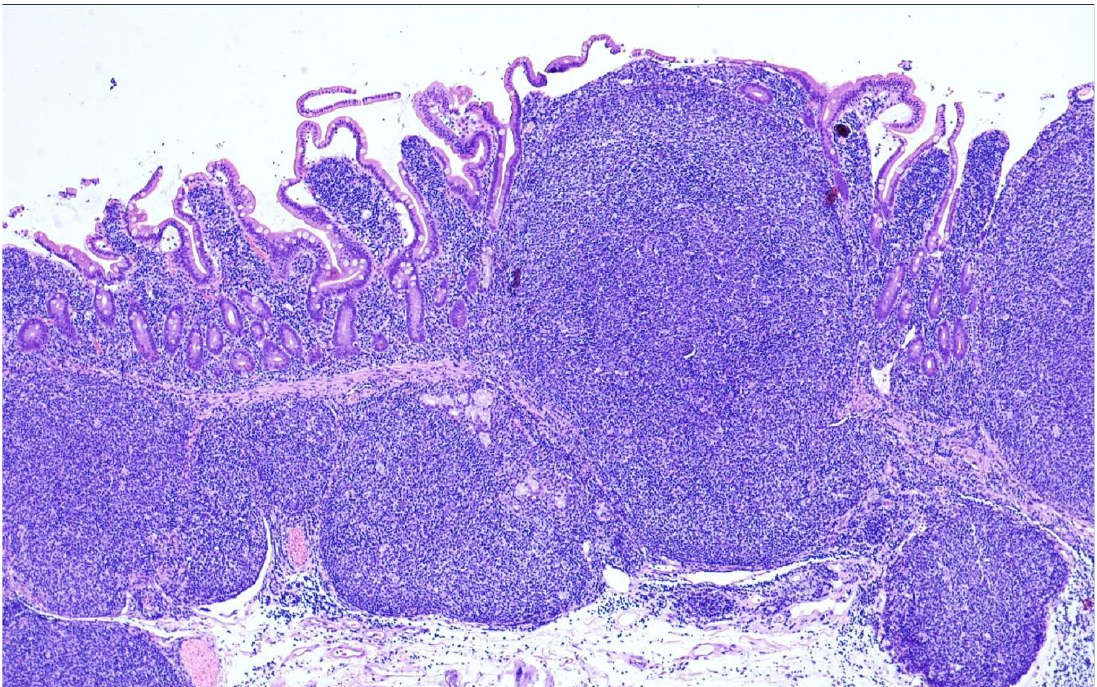
Figure 8. Duodenal-type follicular lymphoma (H&E ×40). Low magnification shows large, atypical nodules/follicles occupying the mucosa and extending into the upper part of the submucosa in this duodenal resection specimen. There is an absence of polarization of the follicles that are composed nearly exclusively of small